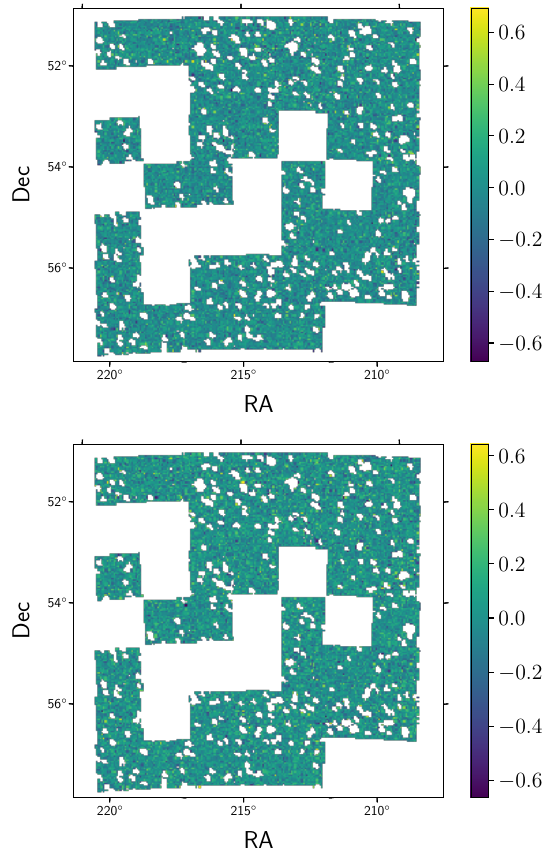
Figure 4. Maps used in this analysis for the W3 field and sixth redshift bin. The top panel is the map of γ 1 (ˆ n ) while the bottom panel is the map of γ 2 (ˆ n